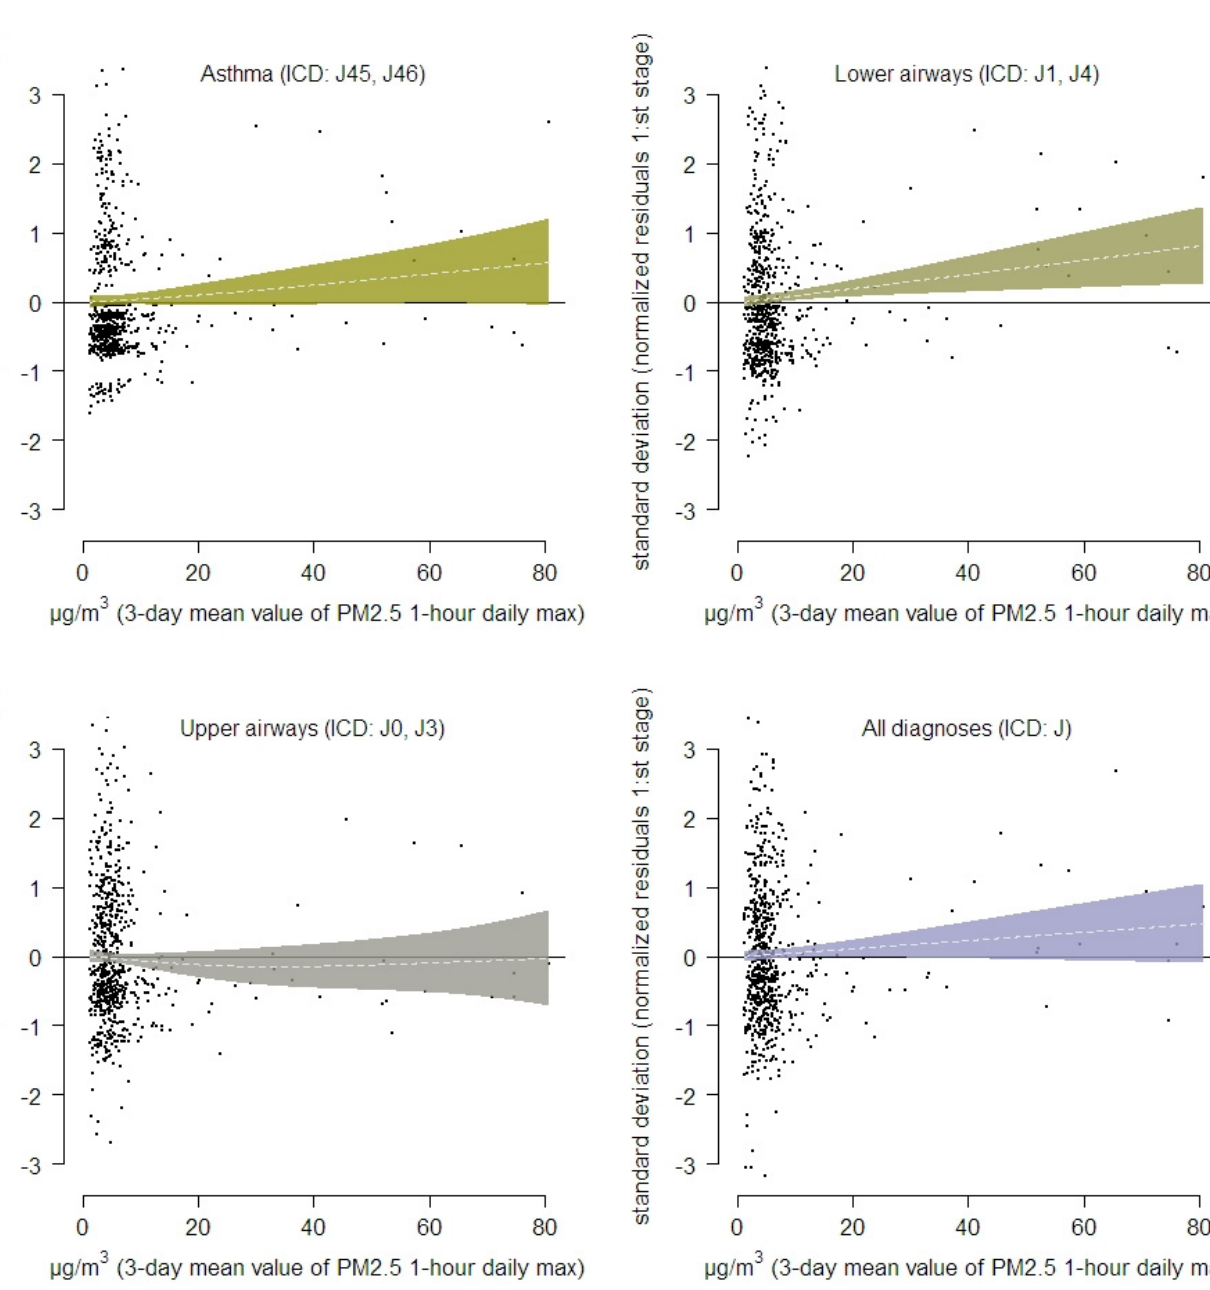
Figure 6. Overall associations between modelled exposure to PM 2.5 and different healthcare visits including the municipalities of Berg, Härjedalen, Åre and the city of Östersund.